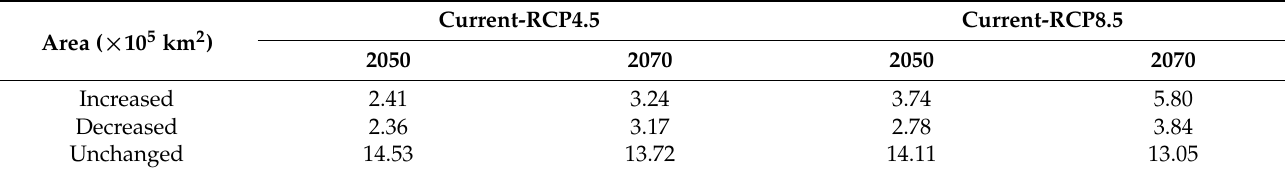
Table 5. Dynamic changes in the potential suitable regions for Cypripedium japonicum under four future climate scenarios. Area ( × 10 5 km 2